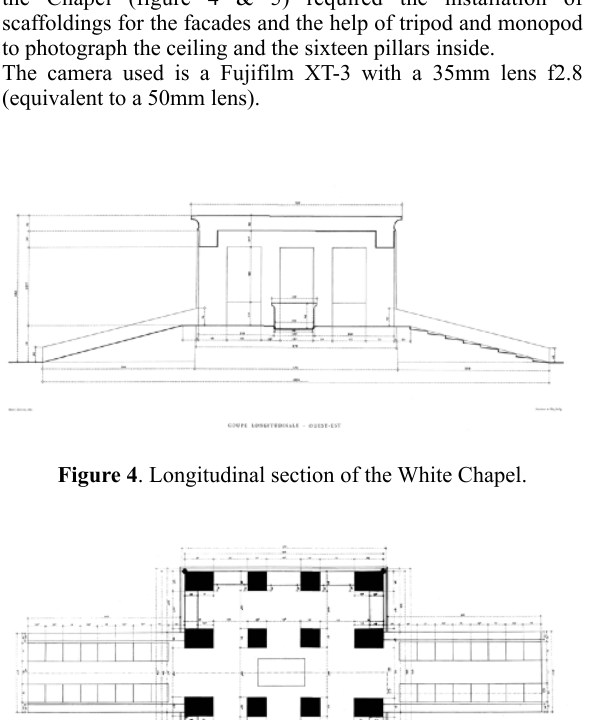
Table 1 . Collected historical photographs of the White Chapel from the CFEETK archives.